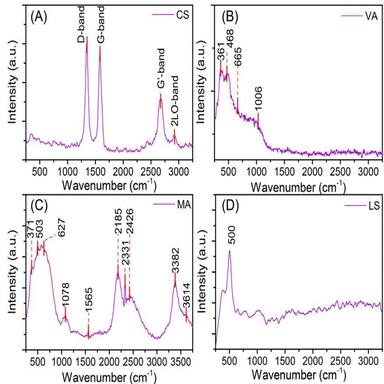
Typical Raman spectra of four different types of single particles measured by the OT-RS. (A–D) are from CS, VA, MA, and LS, respectively.